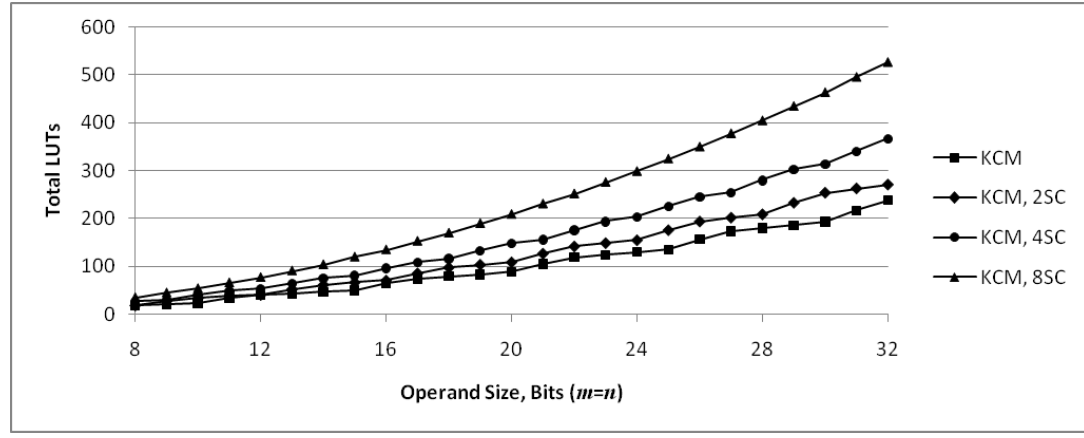
Figure 12. LUT6s required for KCMs with one, two, four and eight coefficients, m = n